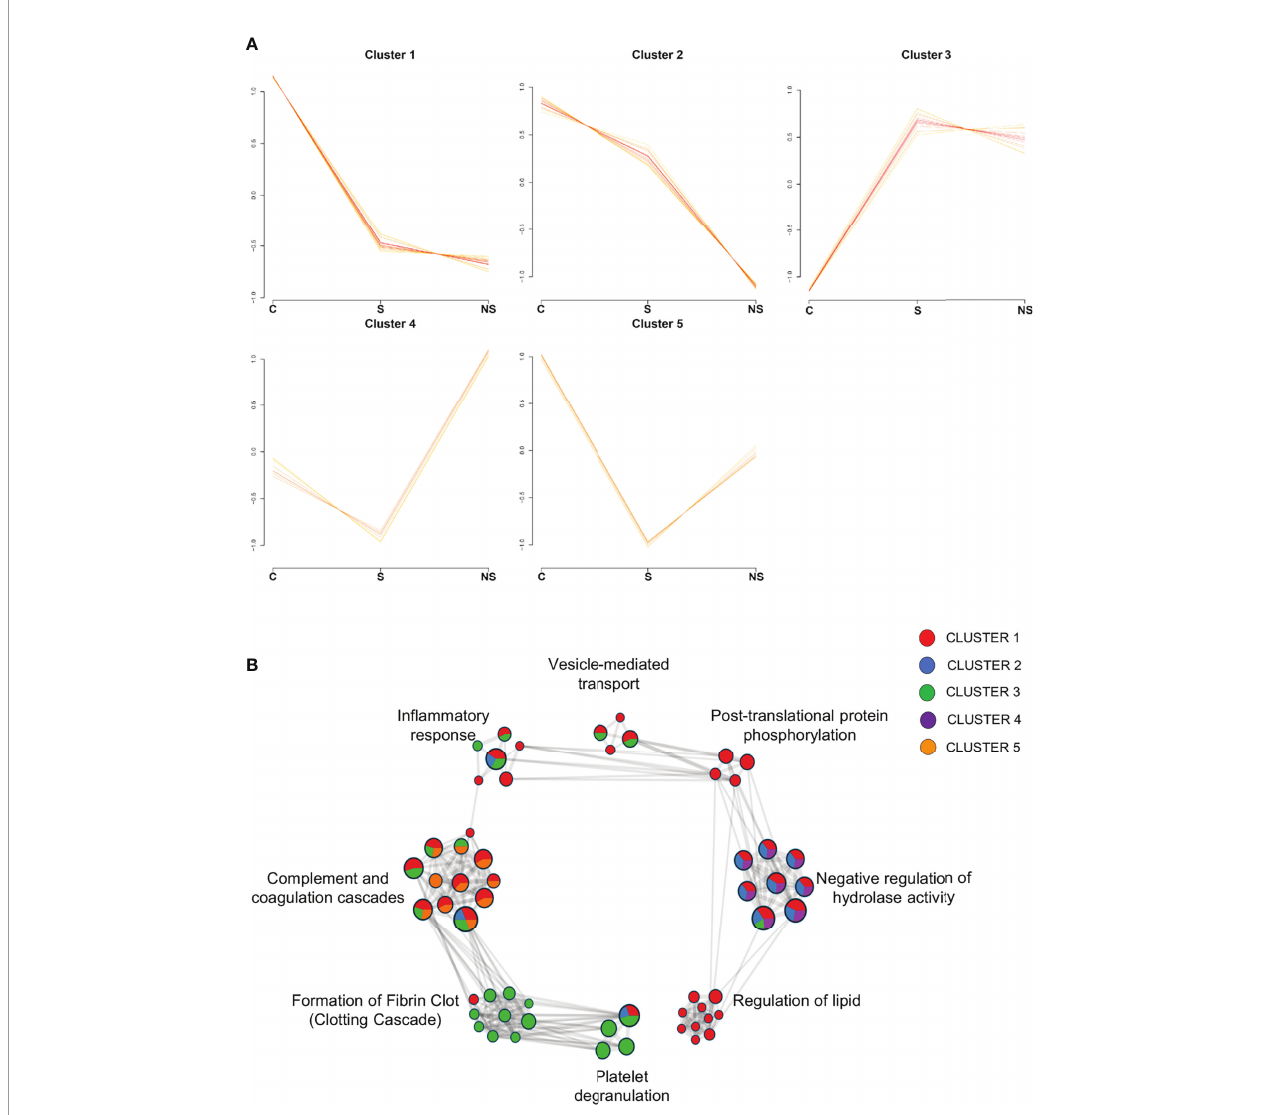
FIGURE 6 | Clusters formed by C vs S vs NS comparison and Network of enriched pathways. (A) Variance sensitive clustering analysis performed in VSClust, which de fi ned the optimum number of clusters as fi ve. (B) Network of enriched terms from protein lists of clusters colored by cluster ID, where nodes that share the same ID are typically close to each other. Pathways database used in Metascape: WikiPathways, GO Biological Process, KEGG, and Reactome. Control group (C), COVID-19 survivors (S), and COVID-19 non-survivors